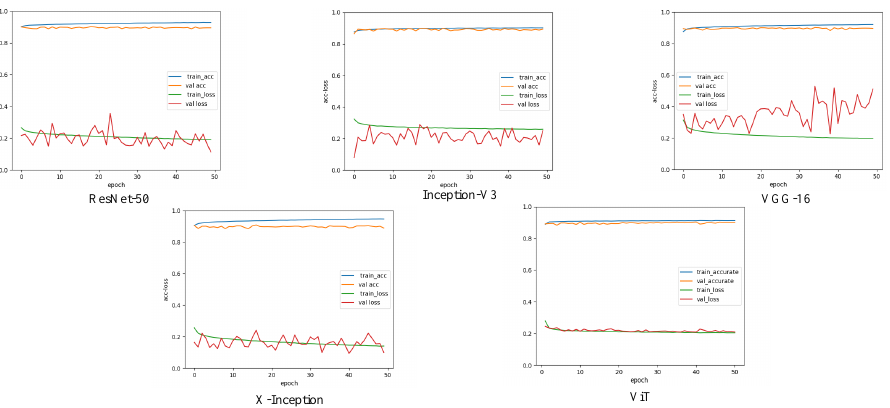
Figure 4. A comparison of the image segmentation results of the loss and accuracy curves of deep learning on 8 × 8 pixels training and validation sets. (Each legend has four curves, respectively, the accuracy and loss values of the training set, and the accuracy and loss values of the validation